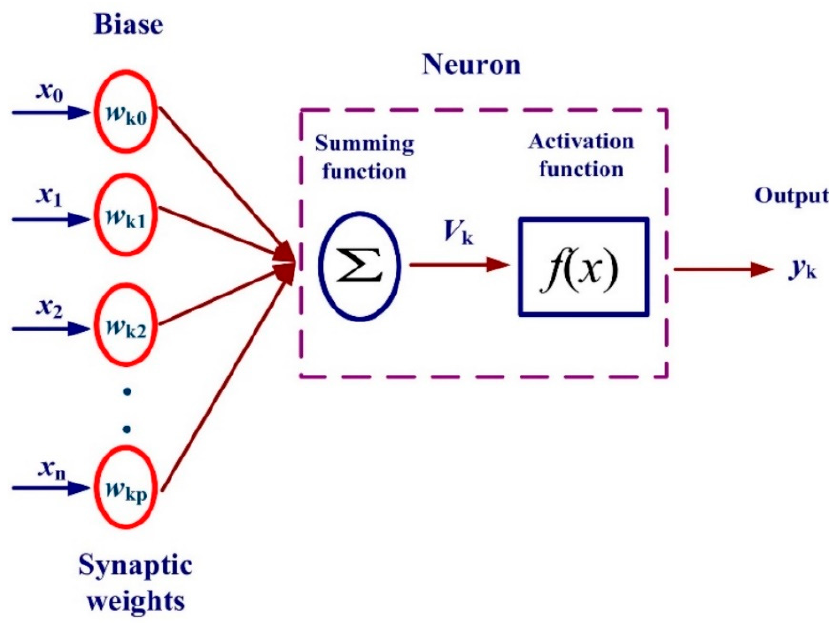
Figure 2. General topology of a single neuron.